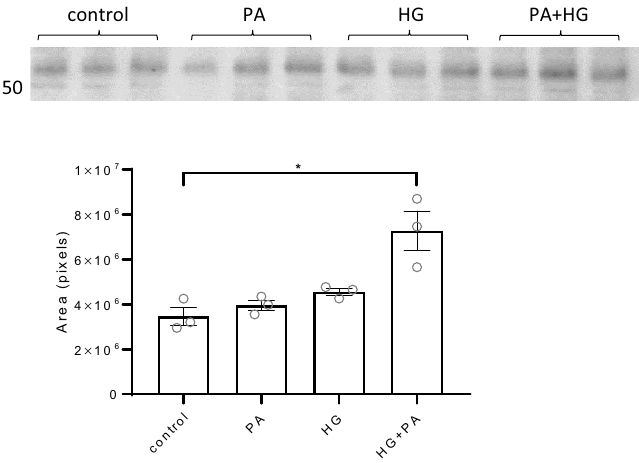
Figure 6. Protein expression of lumican in human glomerular endothelial cells in vitro. Western blot of lumican expression in cells after treatment of human glomerular endothelial cells with high glucose (HG), palmitate (100 µM) bound to HSA (PA) or a combination of both (HG+PA)for 24 h. The band corresponding to lumican was analyzed for protein abundance. The blot presented is a cropped version without ladder and the full blots are presented in Supplementary Figure 1. *P < 0.05, error bars represent